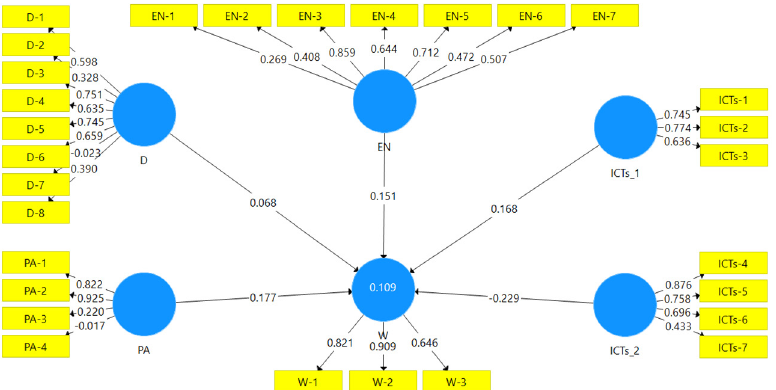
Figure 1. General results of the structural equations model. D: Dietary factors; EN: Environment;